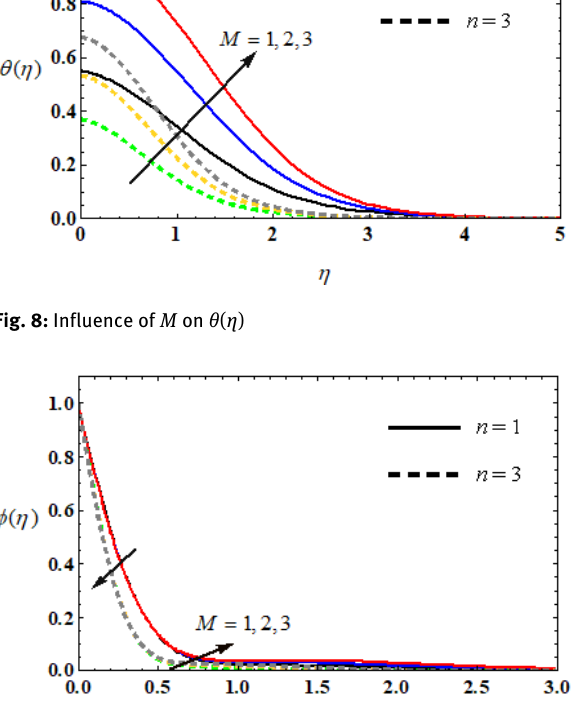
Fig. 9: Influence of M on θ ( η )